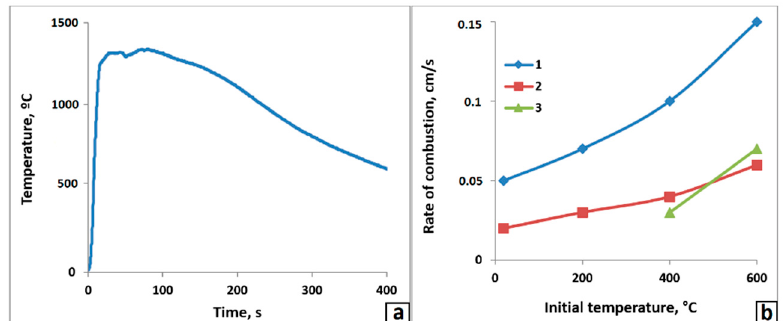
Figure 11. ( a ) Typical temperature profile of ferrochromium nitridation. P N2 —5 MPa, T max = 1280 °C. ( b ) Impact of ( T 0 ) on the rate of ferrochromium combustion. 1 and 2—0.04 mm, 3—0.2 mm; and 1 and 3—6 MPa and 2—2 MPa.